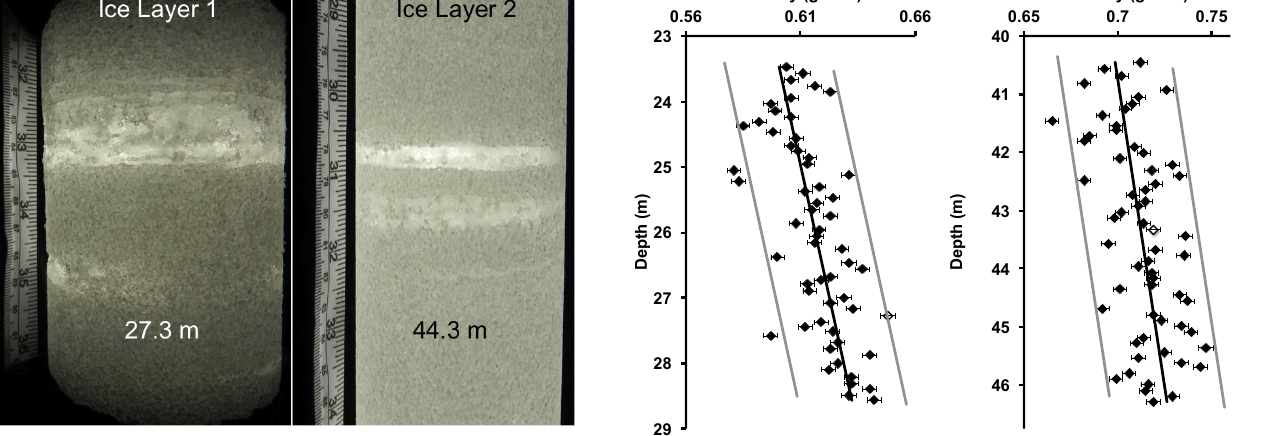
Figure 1. The two ice layers in the 2009 NEEM firn core; (left) ice layer 1 located at 27.3m depth, and (right) ice layer 2 located at 44.3m depth.